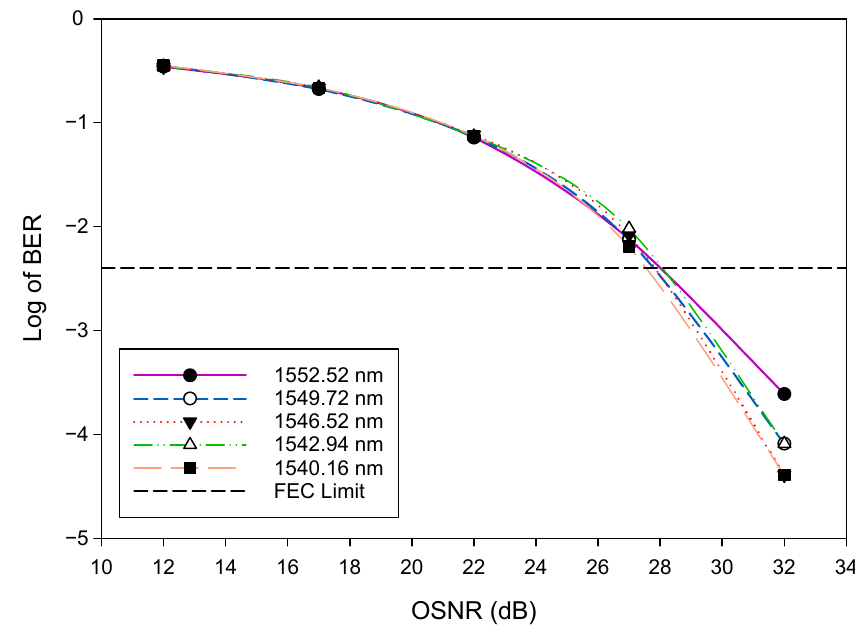
Figure 4. BER versus OSNR plots for selected WDM signals.